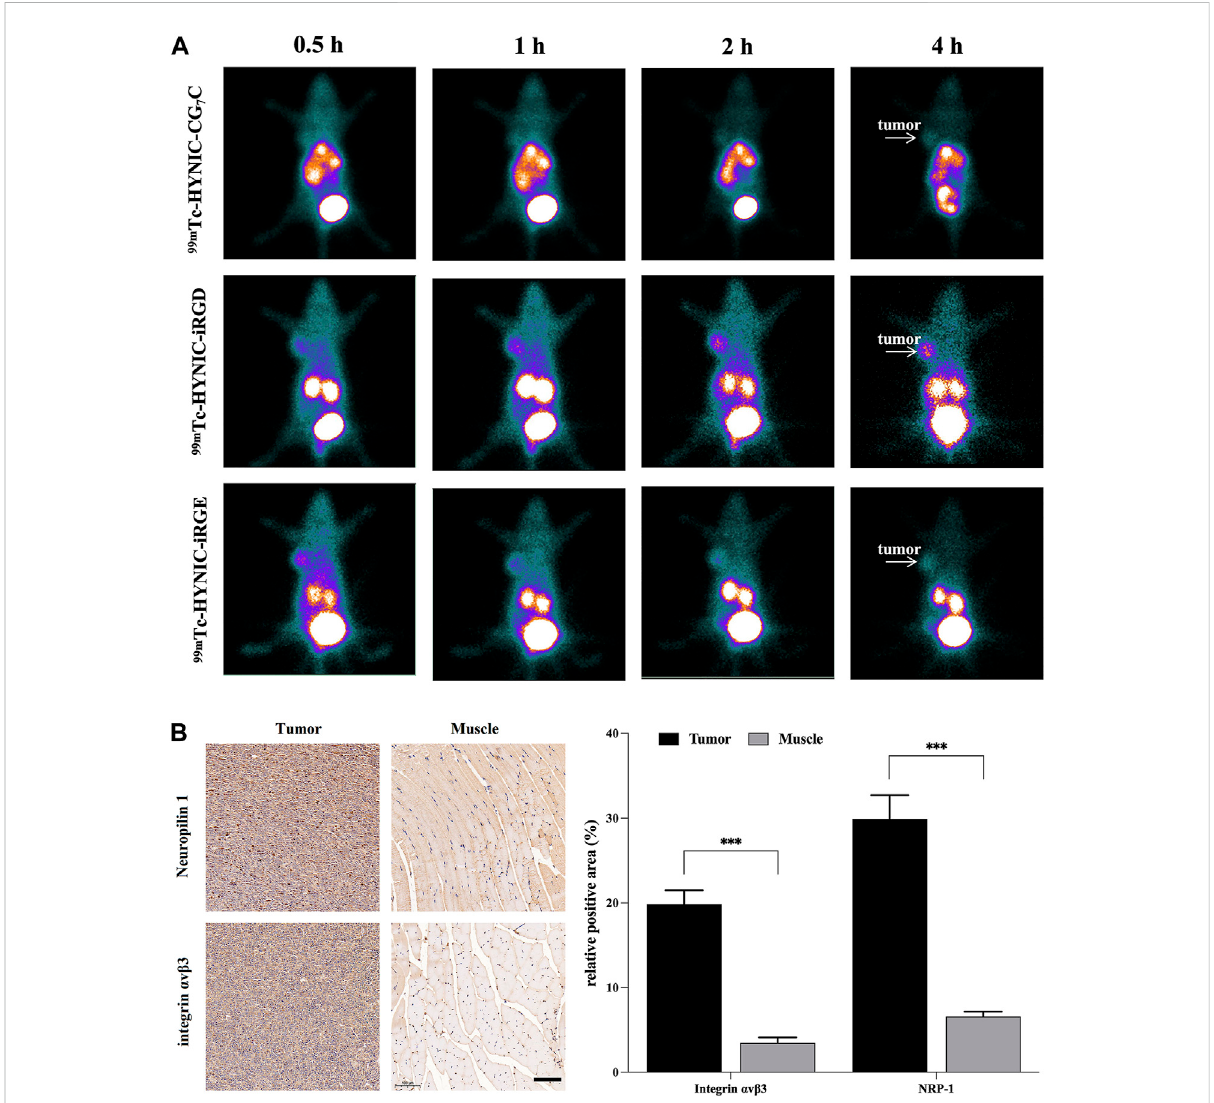
FIGURE 6 (A) SPECT images of 4T1 tumor-bearing nude mice at different time points after intravenous injection of 99m Tc-HYNIC-iRGD, 99m Tc-HYNIC- iRGE, and 99m